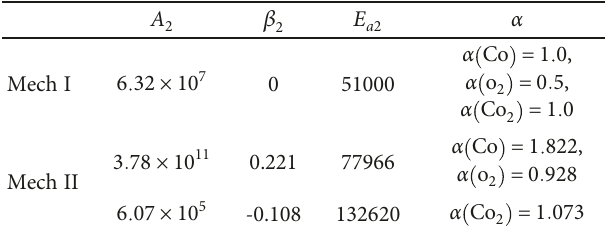
Table 2: Arrhenius parameters for the second reaction (units: kmol, m, s, kJ, and K). Figure 2: Grid resolution of the computational